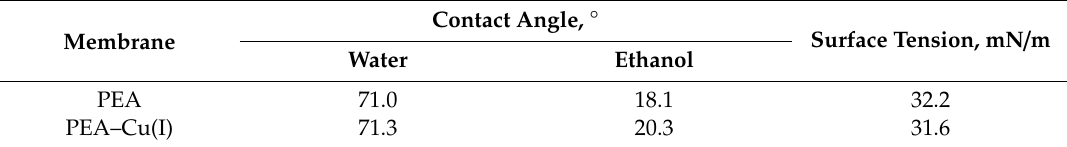
Table 2. Contact angles and surface tension of membranes.